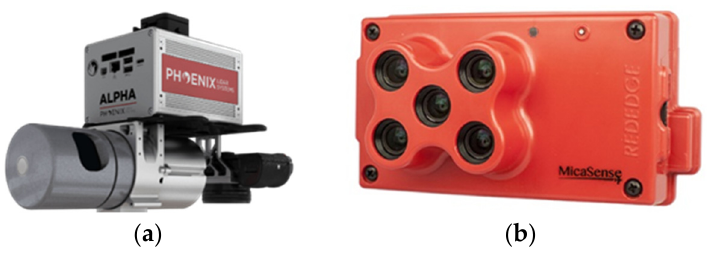
Figure 3. LiDAR ( a ) and imagery ( b ) sensors.